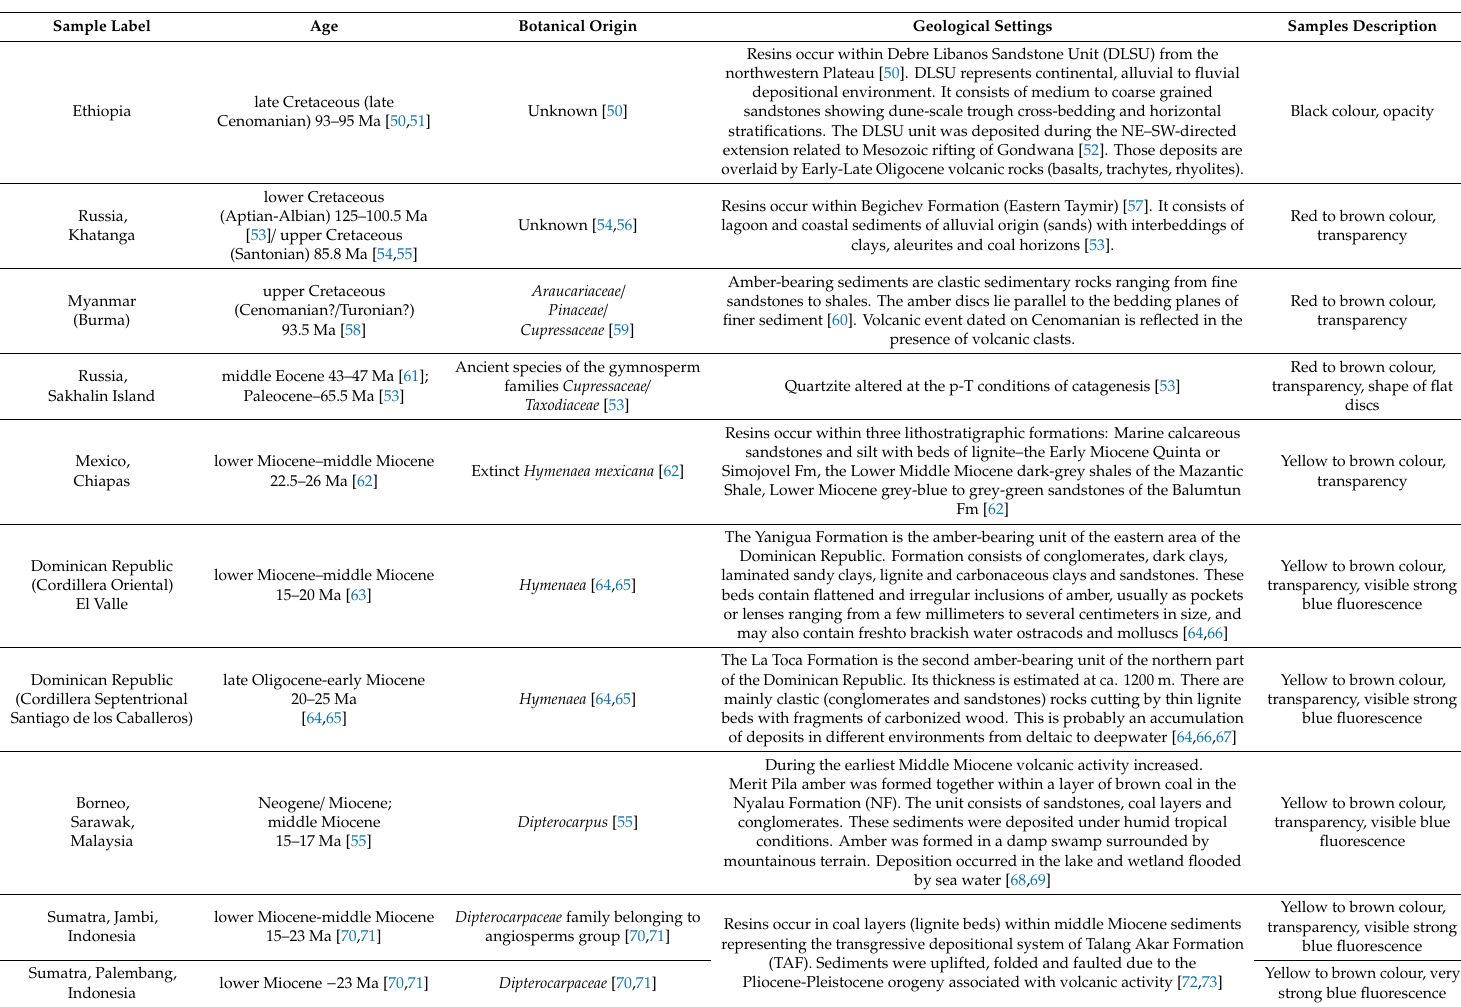
Table 1. Detailed characterization of investigated fossil